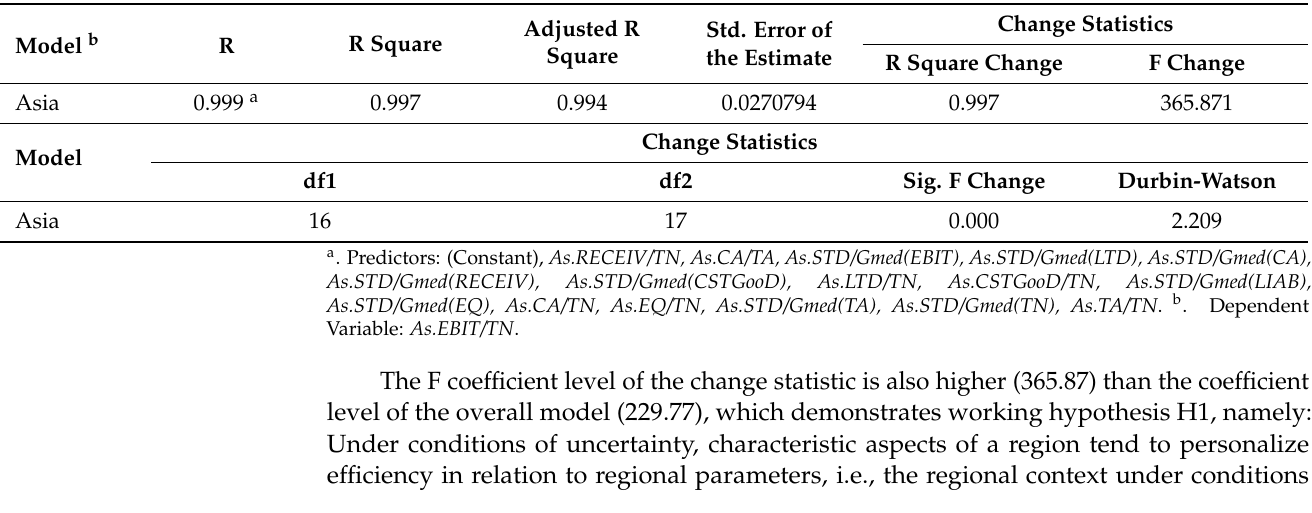
Table 2. Statistical summary of the Asian regional